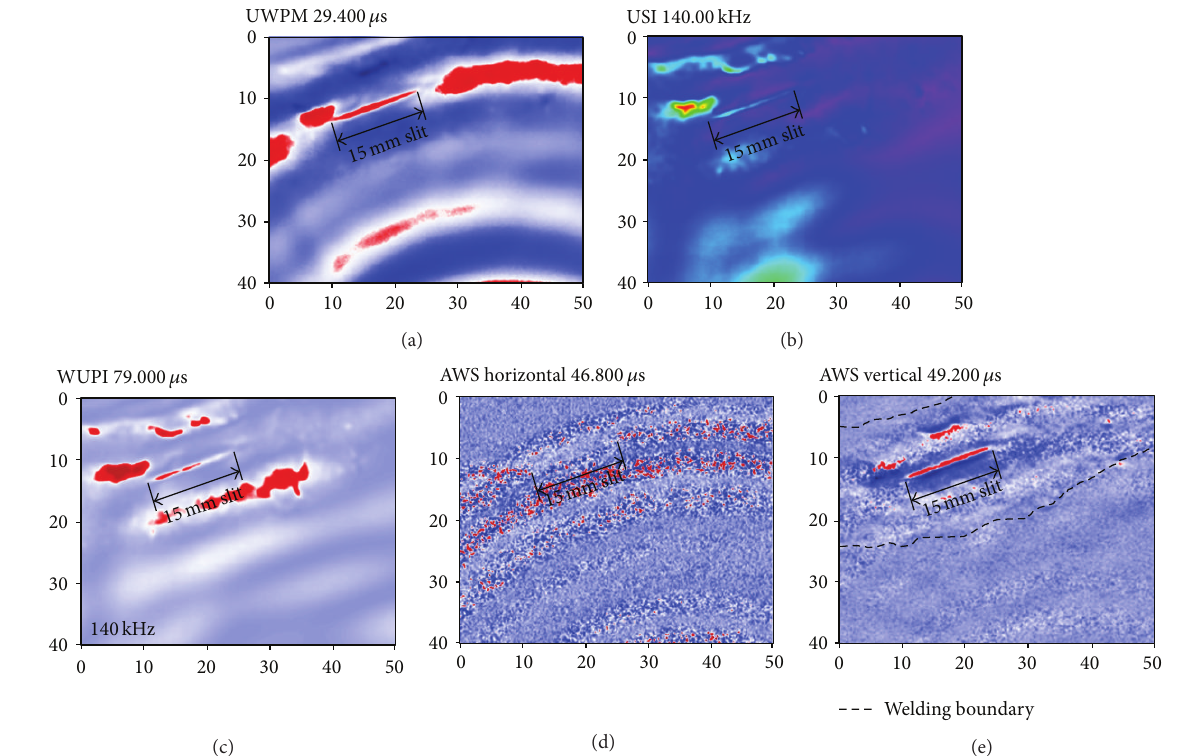
Figure 9: Multiple damage visualization results for a 15mm surface crack in the welding, freeze frames at (a) 29.4 𝜇 s of the UWPI video, (b) 140kHz of the USI video, (c) 79 𝜇 s and 140kHz of the WUPI video, (d) 46.8 𝜇 s of the horizontal AWS video, and (e) 49.2 𝜇 s of the vertical AWS